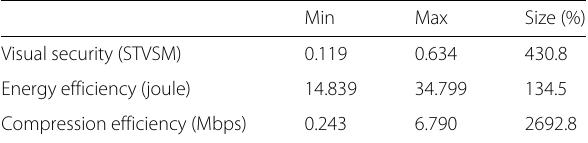
maximum in terms of the visual security, the compression efficiency, and the energy efficiency (Foreman